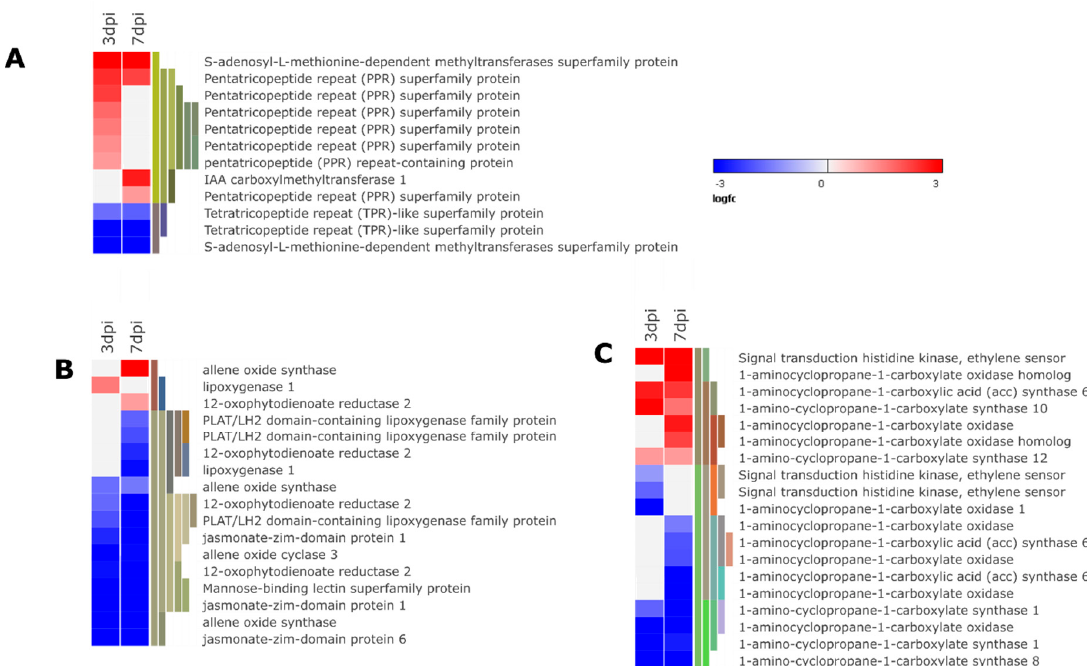
Figure 6. Heat map illustration of differentially expressed genes involved in hormone signal transduction. (A) Salicylic signaling pathway. (B) Jasmonic signaling pathway. (C) Ethylene signaling pathway. (The heat map illustrates a subset of genes from each group. Refer supporting information for all differentially expressed genes in each group).